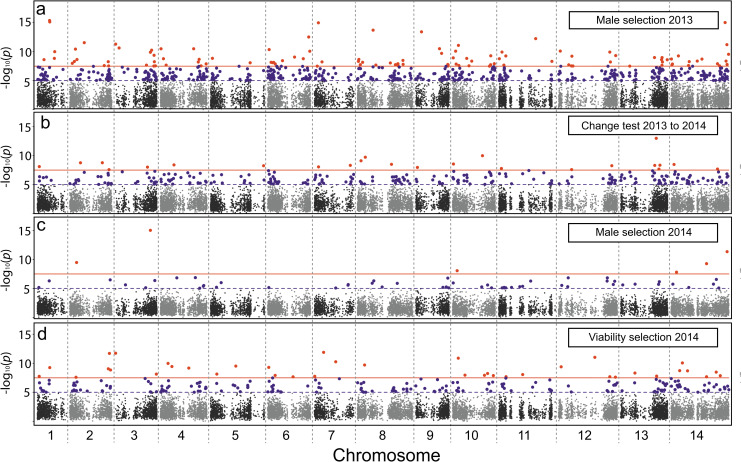
Manhattan plots, with a single test reported per gene, for (a) Male selection 2013, (b) Allele frequency change 2013–2014, (c) Male selection 2014, and (d) Viability selection 2014. The orange line is the Bonferroni threshold, purple is p = 10−5.